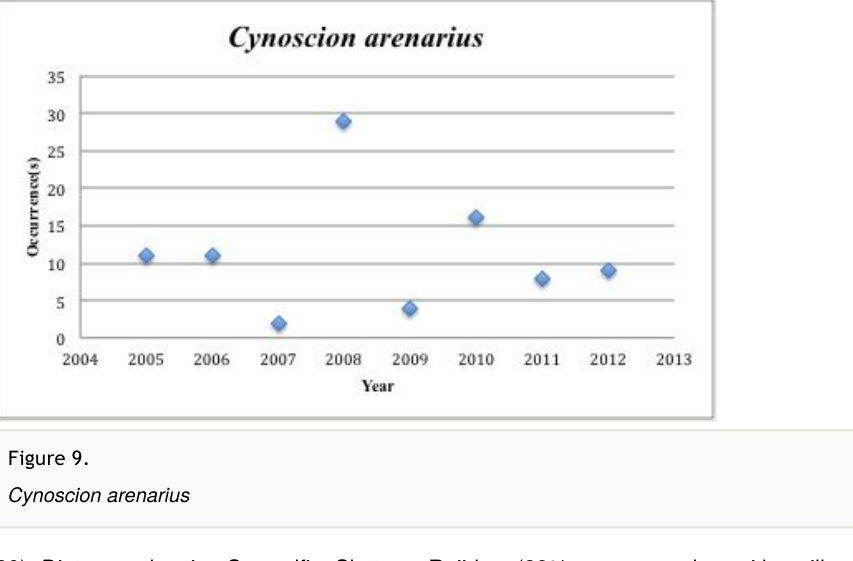
Figure 9. Cynoscion